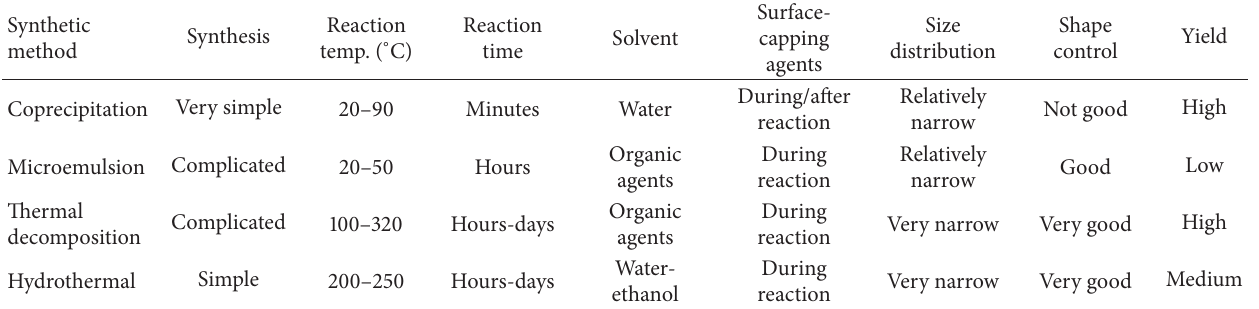
Table 4: The comparison of key properties of different synthetic methods